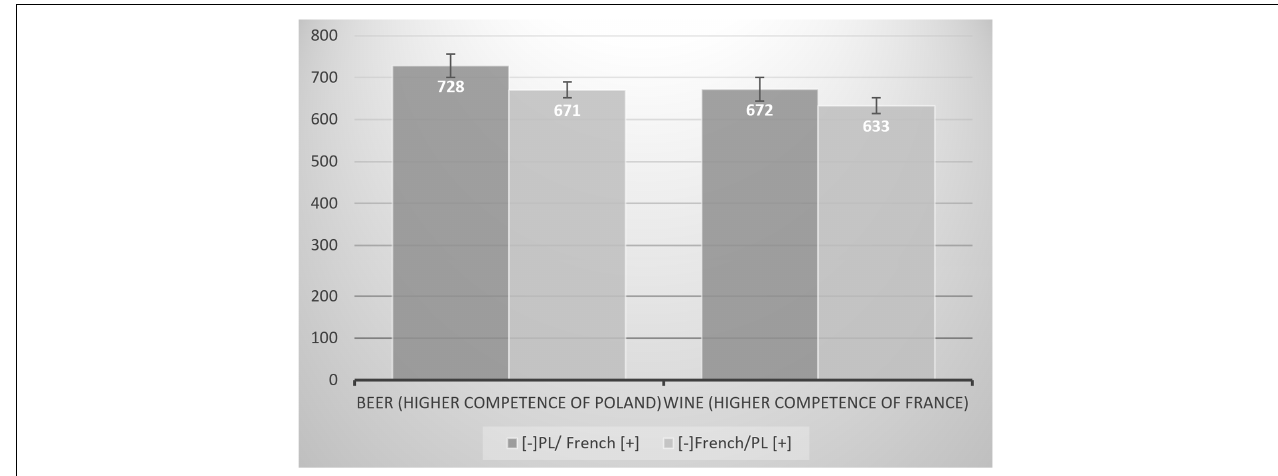
FIGURE 4 | Comparison of ICE toward Polish (local) vs. French (foreign) existing brands (IAT effect) in two product categories of different levels of competence: (a) beer – higher competence of Poland and (b) wine – higher competence of France. Categorization time in milliseconds